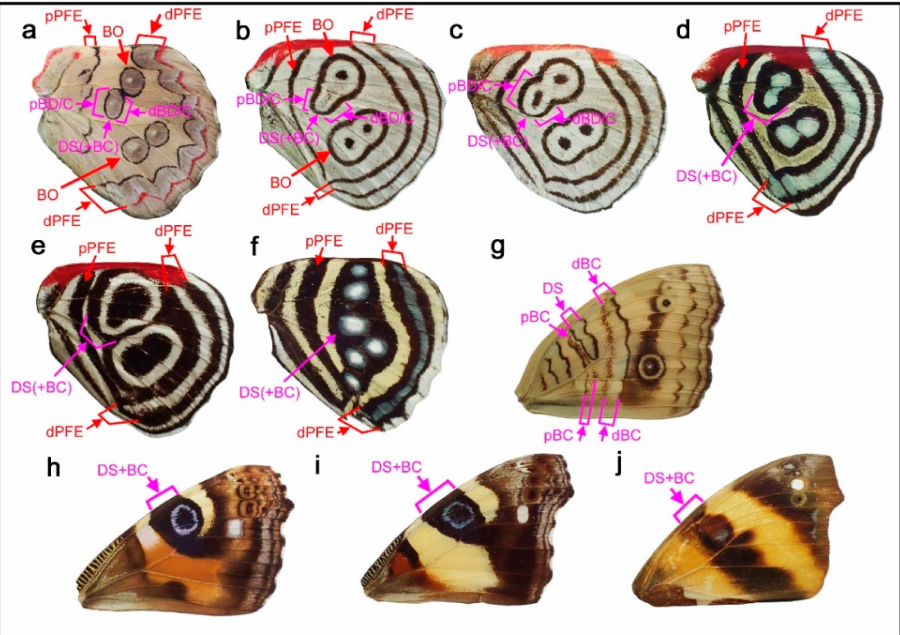
Figure 4. Circular patterns of the discal spot in the family Nymphalidae. ( a ) Diaethria bacchis . ( b , c ) Diaethria neglecta . ( d ) Diaethria ( Catacore ) kolyma . ( e ) Diaethria clymena . ( f ) Callicore hesperis . ( g ) Junonia almana . ( h ) Vanessa ( Bassaris ) gonerilla . ( i ) Vanessa ( Bassaris ) itea . ( j ) Epiphile dinora